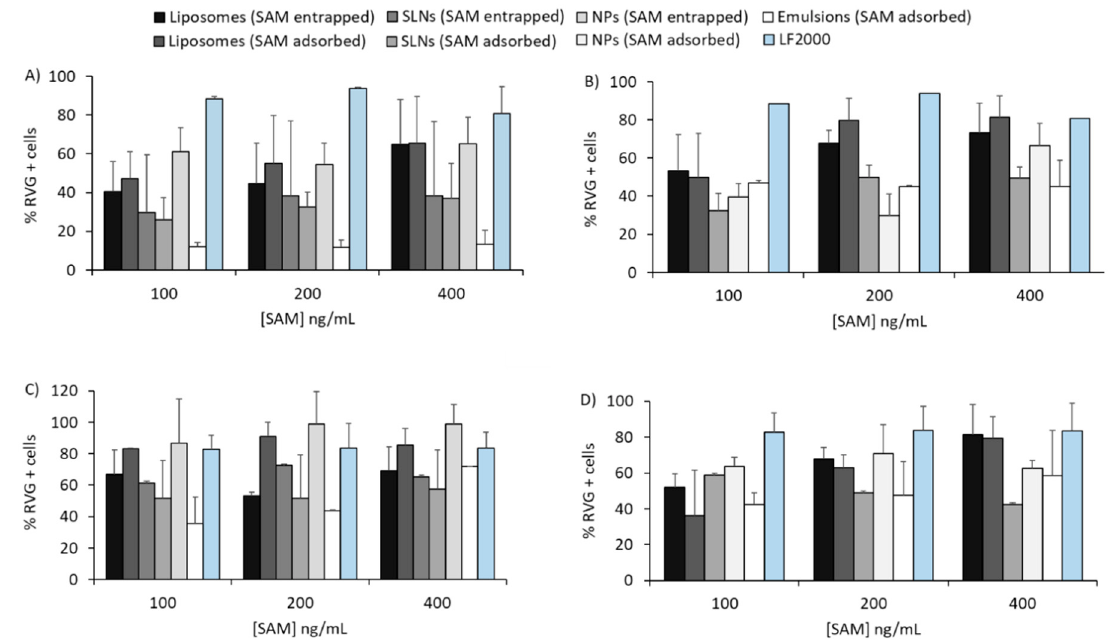
Figure 3. In vitro potency (IVP) in BHK cell line. IVP in BHK in either 5% FCS ( A and B ) or FCS-free ( C and D ) medium of DOTAP-based (A and C) and DDA-based (B and D) formulations prepared with SAM-RVG at different concentrations. Lipofectamine 2000 (LF2000) was used as a positive control. Results are represented as mean ± SD of 3 independent experiments.